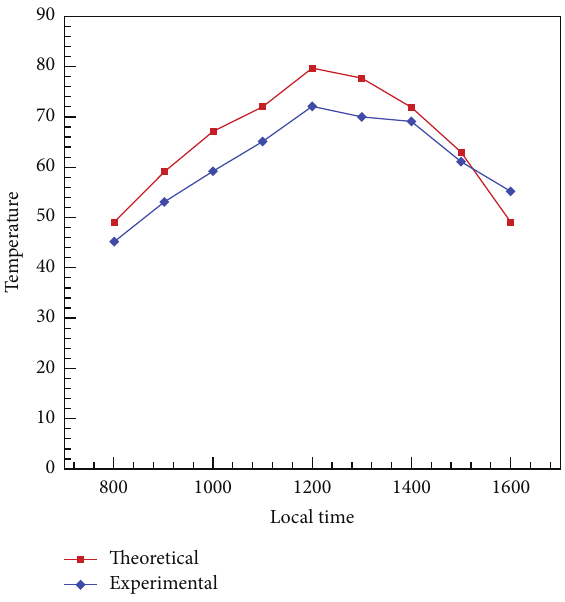
Figure 8: Comparison of analytical and experimental